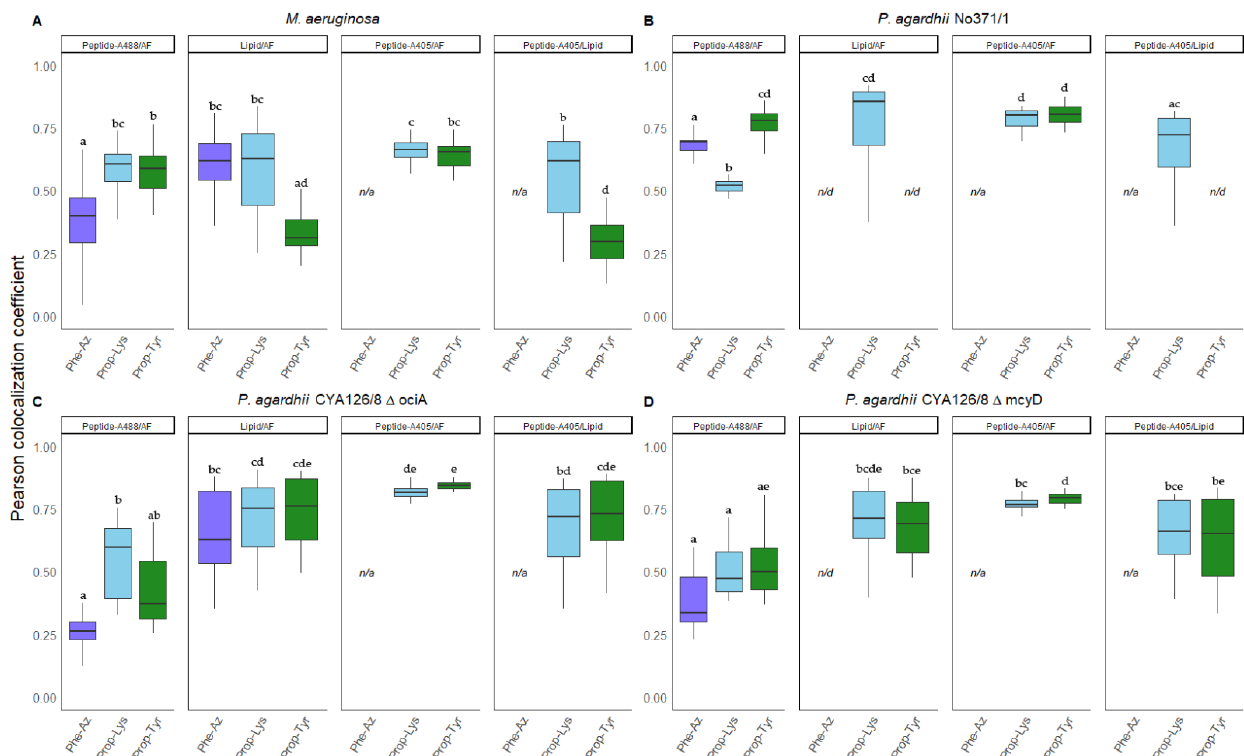
Figure 6. Pearson colocalization coefficients (PCC) calculated for ( A ) M. aeruginosa , ( B ) P. agardhii No371/1, ( C ) P. agardhii , ∆ ociA and ( D ) P. agardhii , ∆ mcyD strains showing both significant labeling with ALEXA488 (green channel), ALEXA405 (blue channel) and BODIPY 505/515 (green channel). Pairwise statistical analysis between the PCC values were calculated i.e., ALEXA488 labeled peptides and natural autofluorescence (AF), BODIPY 505/515 stained lipids and AF, ALEXA405 labeled peptides and natural AF and ALEXA405 labeled peptides, and BODIPY 505/515 stained lipids. Superscripts indicate statistically significant different subgroups after overall difference was found ( p < 0.05); n/d: no data; n/a: not applicable.